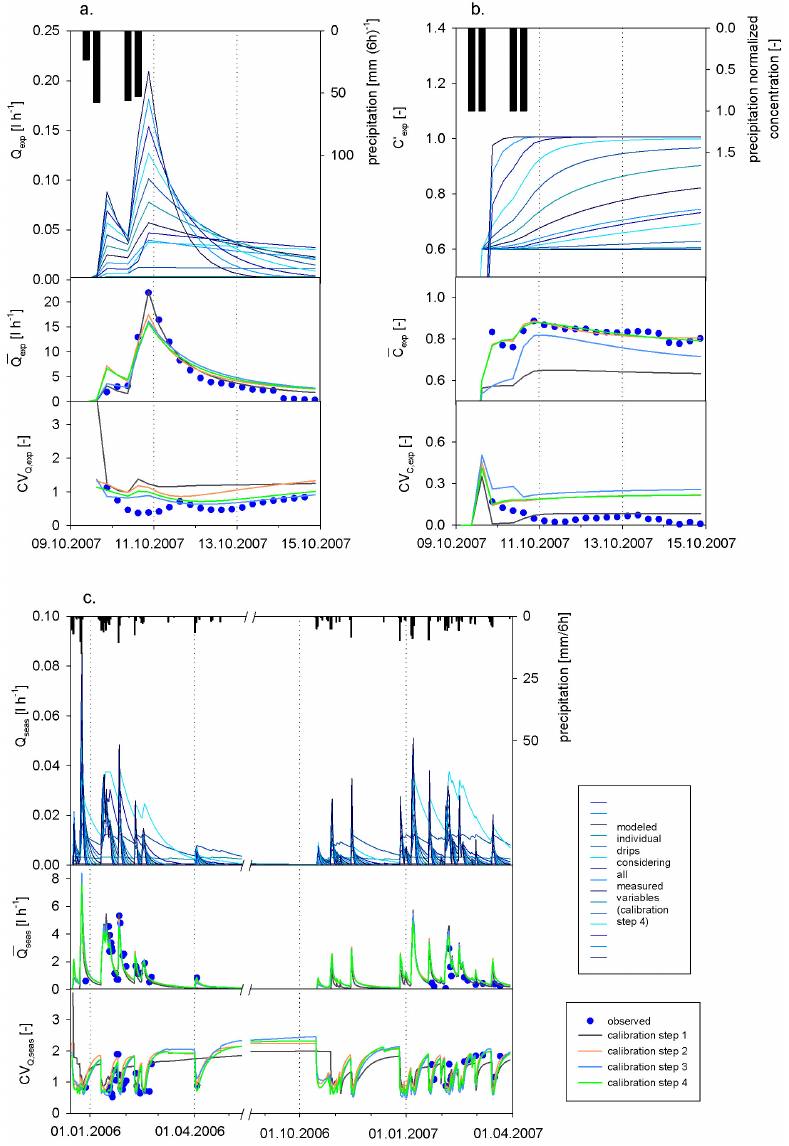
Fig. 6. Simulation results of all individual model compartments for calibration step (4) and the integrated responses and CVs of all calibration steps for (a) drip rates during the sprinkling experiment, (b) drips’ concentrations during the sprinkling event, and (c) drip rates at the seasonal time